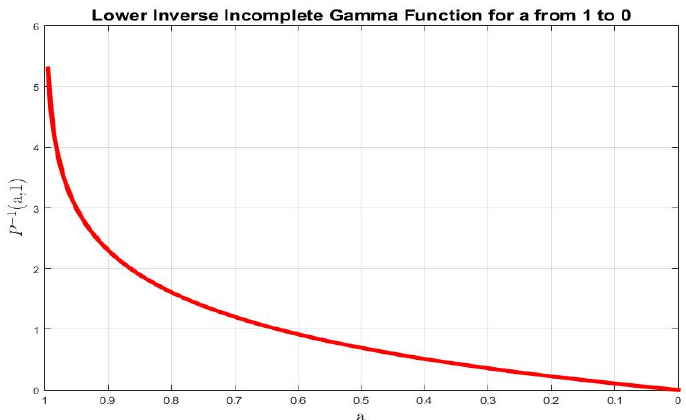
Figure 4. The behavior of the inverse incomplete gamma function with respect to 𝑎 values.